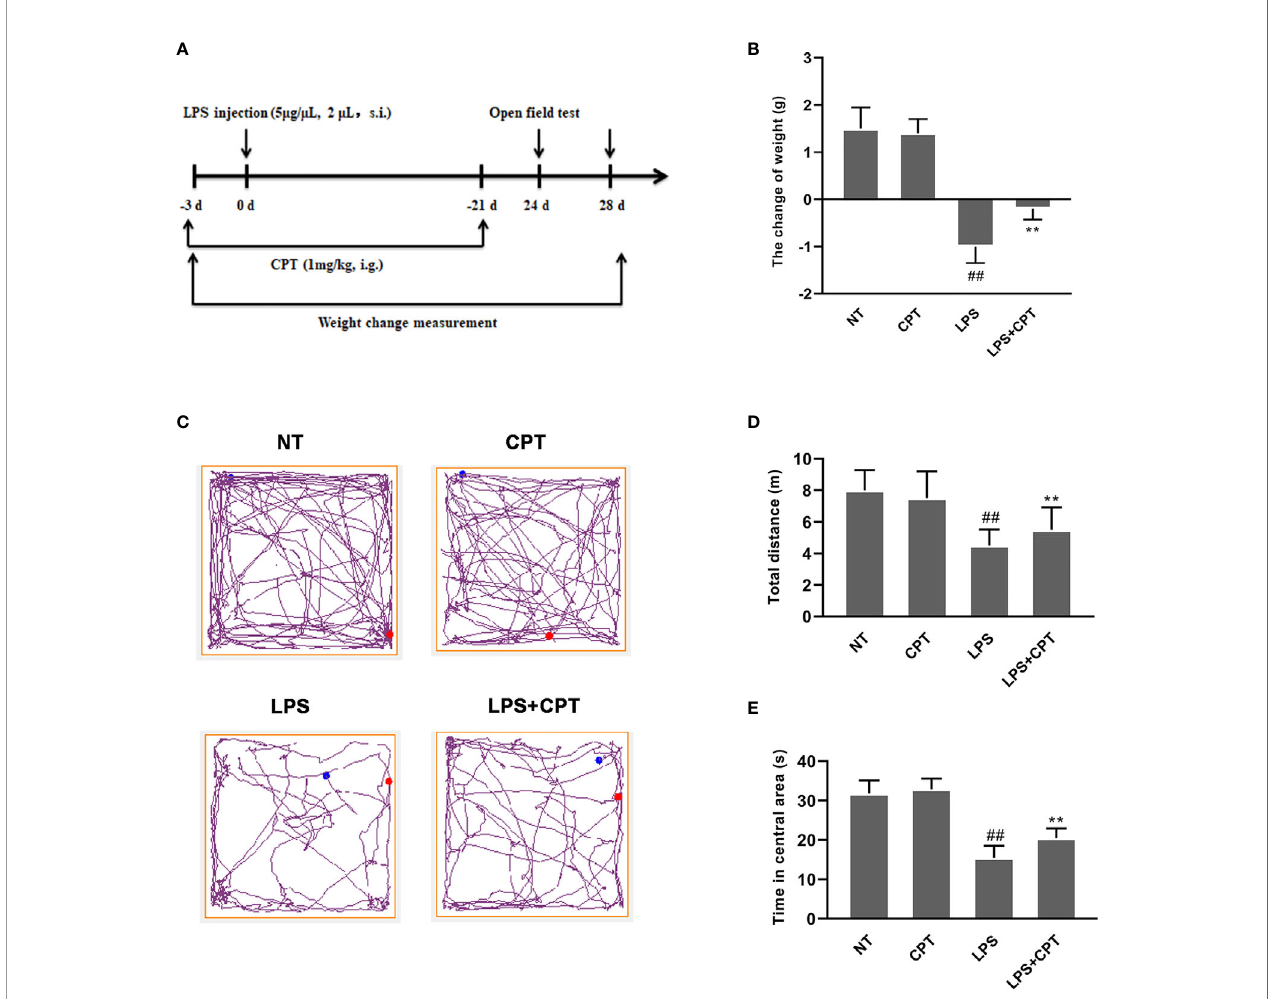
FIGURE 1 | CPT treatment alleviates the weight loss and behavioral disorder of LPS-injected PD mouse model. (A) Experiment procedure. Mice were injected with LPS (5 m g/ m L, 2 m L) or equal volume PBS into the right SNpc after anesthesia and treated every two days with CPT (1 mg/kg) for 3 days before surgery and for a total of 24 days. (B) The weight change of mice during the experiment. Before the operation and on the 28th day after the operation, the body weight of mice was measured. (C-E) The locomotor activity of mice was tested using the open fi eld assay. Results are shown as means ± SD (n= 5). ## p < 0.01 vs. the no-treatment (NT) group; **p < 0.01 vs. the LPS-injected